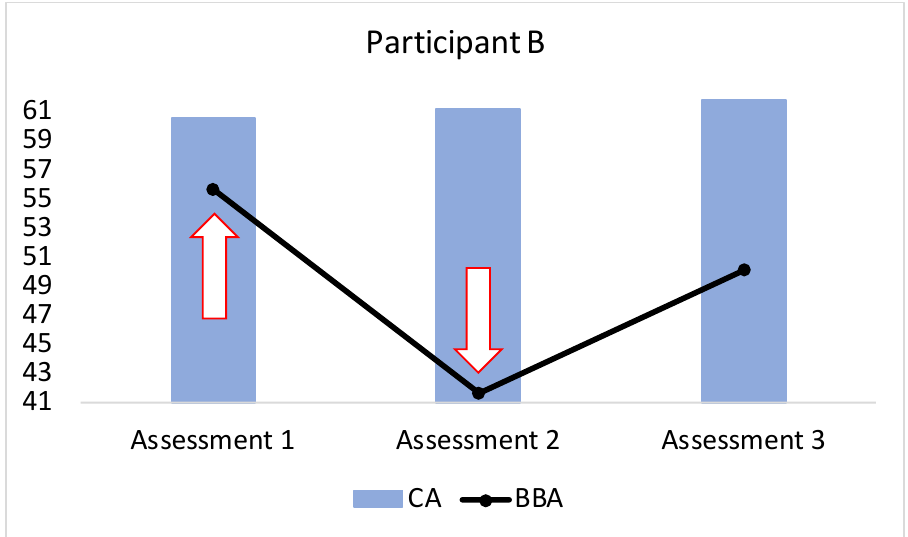
Figure 7. Intervention-induced changes in BBA as a function of nutraceutical supplementation across three assessments. The y -axis represents years for the BBA and CA. CA: chronological age; BBA: biological brain age. The arrow pointing up indicates the start of the intervention, and the arrow pointing down indicates the end of the intervention.